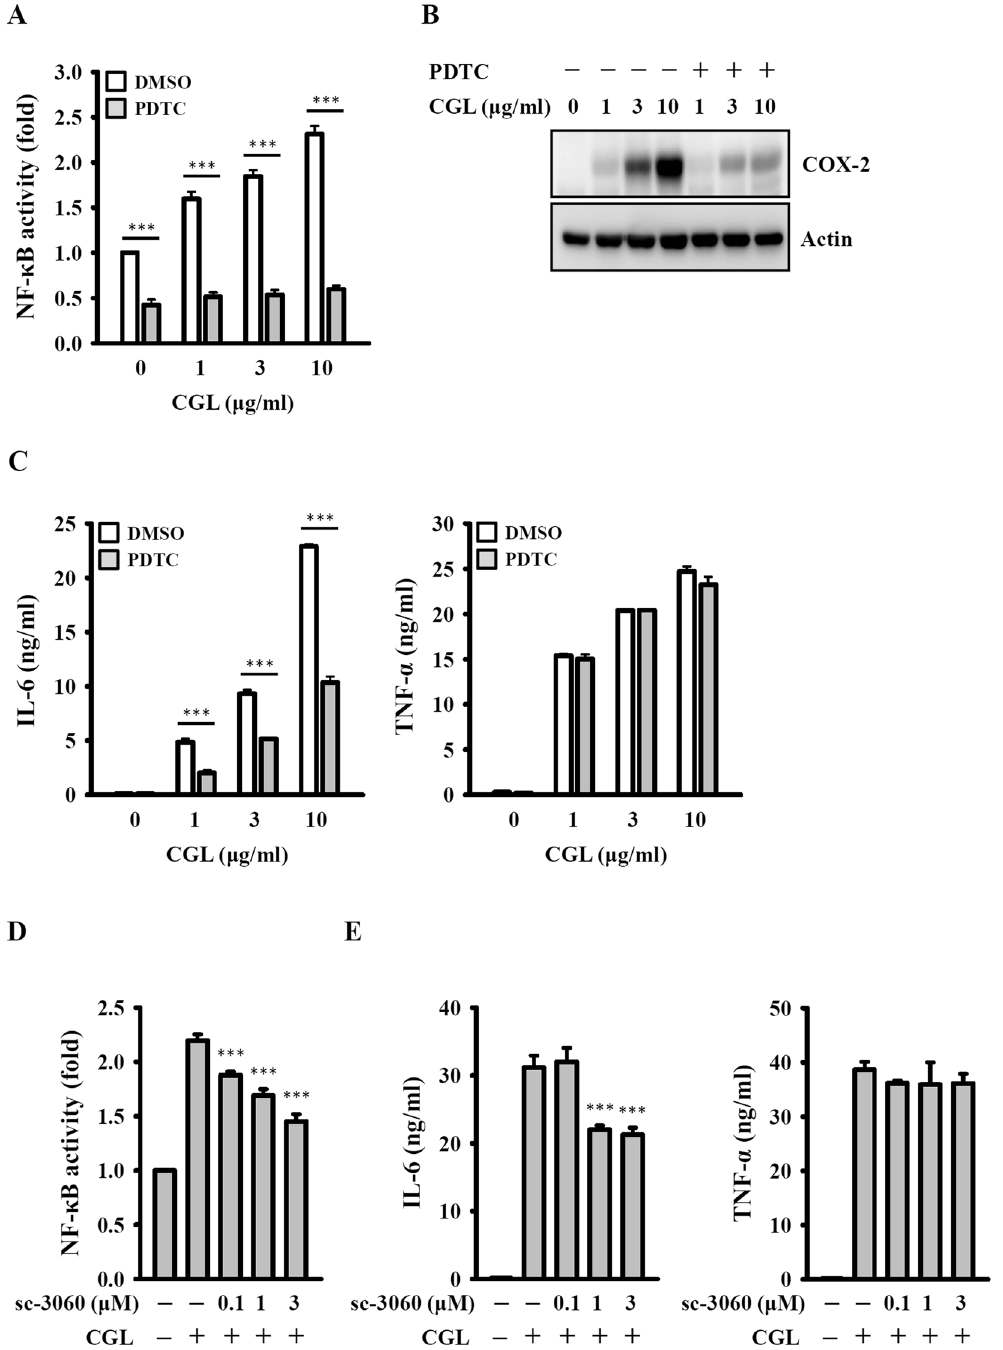
Figure 5. CGL induced TNF- α and IL-6 secretion through NF- κ B. ( A ) RAW-Blue TM cells were incubated for 30 min with or without PDTC (30 µ M), followed by incubation for 24 h with or without CGL. The activation levels of NF- κ B were measured by NF- κ B reporter assay. ( B and C ) RAW264.7 macrophages were incubated for 30 min with or without PDTC (30 µ M), followed by incubation for 24 h with or without CGL. The levels of COX-2 in the cell lysates were measured by Western blot ( B ), and IL-6 and TNF- α in the culture medium were measured by ELISA ( C ). ( D ) RAW-Blue TM cells were incubated for 30 min with or without sc-3060, followed by incubation for 24 h with or without CGL (10 µ g/ml). The activation levels of NF- κ B were measured by NF- κ B reporter assay. ( E ) RAW264.7 macrophages were incubated for 30 min with or without sc-3060, followed by incubation for 24 h with or without CGL (10 µ g/ml). The levels of IL-6 and TNF- α in the culture medium were measured by ELISA. Western blot results are representative of those obtained in three different experiments. The ELISA data are expressed as the means ± SD of three separate experiments. *** Indicates a significant difference at the level of p < 0.001 compared to CGL-treated cells. The blots in ( B ) were cropped; full-length blots are included in the “Supplementary